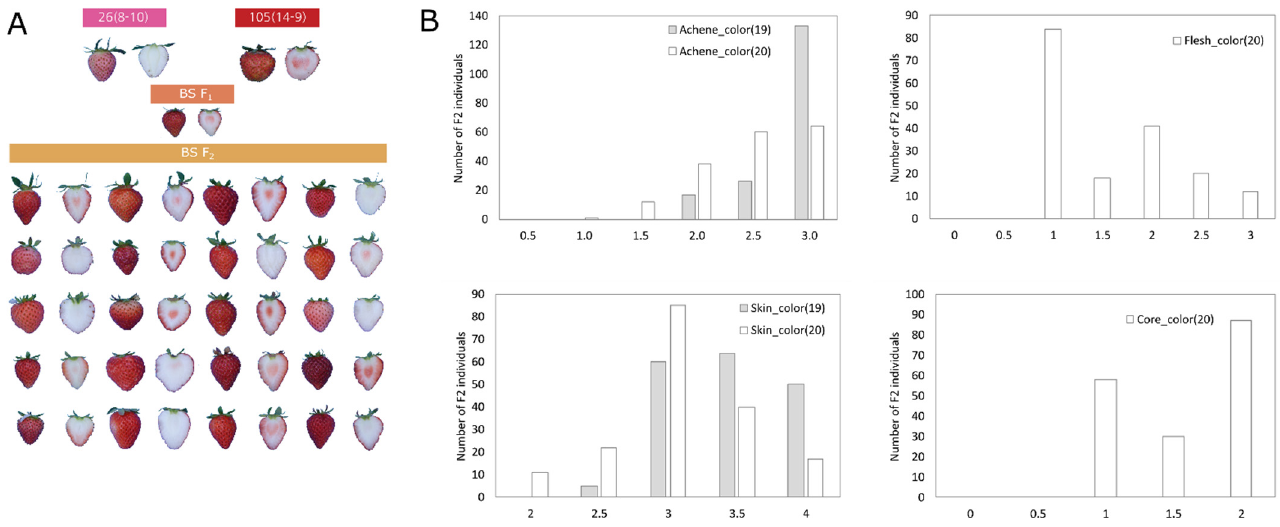
Figure 5. ( A ) Phenotype of ‘BS F 2 (II)’ fruits utilized for the fruit color QTL identification evaluated for 2019 and 2020. ( B ) Distribution of fruit color related traits in ‘BS F 2 (II)’. Table 2. QTLs for fruit color detected in the ‘BS F 2 (II)’ population .